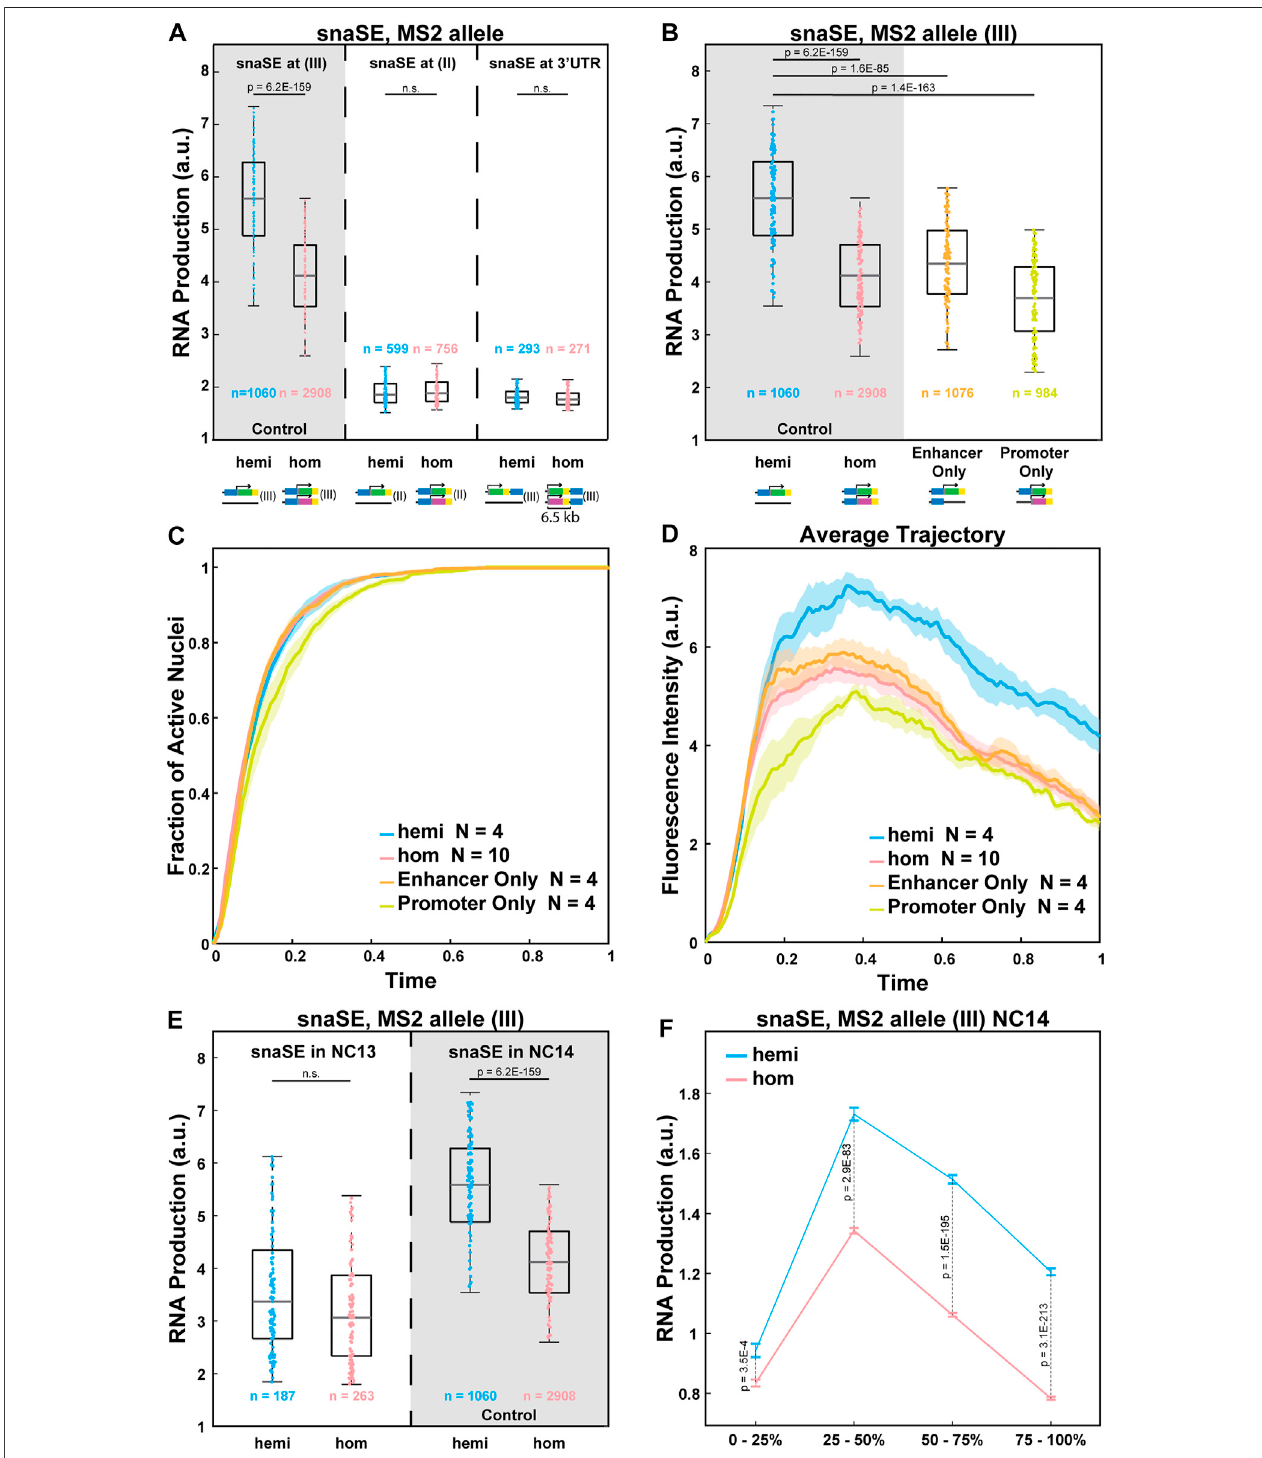
FIGURE 3 | Allelic competition is not observed when the enhancer-promoter interactions are weakened. (A) Plots comparing the RNA production of the MS2- yellow allele between the homozygous and the hemizygous constructs of snaSE > yellow (III), snaSE > yellow (II) and snaSE3 ’ > yellow . Thehomozygous allelesofthe latter two constructs donot compete with each other. Thesimpli fi edschematicsoftheconstructsare shown under each genotype. n indicates thenumber ofanalyzednuclei from 4, 10, 4, and 4 biologically replicate embryos of each genotype, respectively. (B) Boxplots showing RNA production of the MS2-yellow allele from the hemizygous, homozygous, Enhancer Only and Promoter Only embryos containing snaSE > yellow . The simpli fi ed schematics of the constructs are shown under each